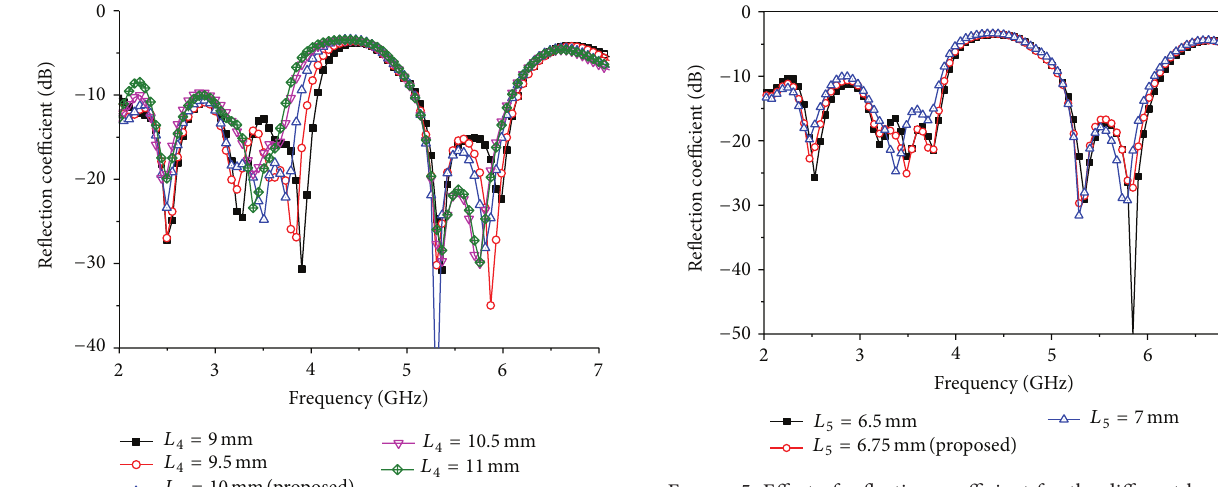
Figure 5: Effect of reflection coefficient for the different length of ground slit 𝐿 5 .